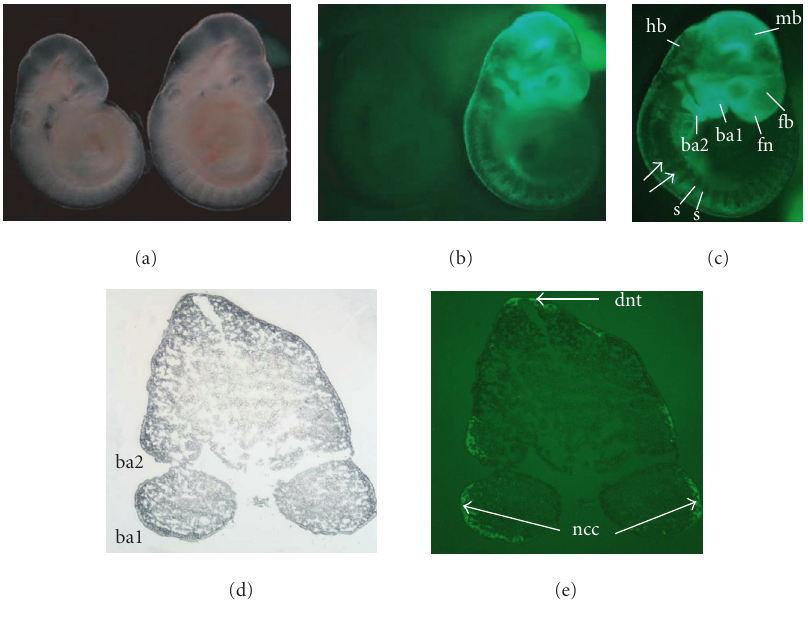
Figure 1. (Top) EGFP-labeled NCC in Wnt 1- Cre/Z/EG transgenic mouse embryos. Photomicrograph of a 9 . 5-dpc, two-component Wnt 1- Cre/Z/EG transgenic embryo (right) adjacent to a wildtype littermate (left) under darkfield optics (a) and epifluorescence optics (b). (c) A 9 . 5-dpc, two-component Wnt 1- Cre/Z/EG transgenic embryo photographed under epifluorescence optics showing EGFP expression in the NCC of the first and second branchial arches (ba1 and ba2), and in the NCC in the forebrain (fb) and from frontonasal (fn) region as well as in Wnt1 expressing cells of the midbrain/hindbrain (mb and hb). EGFP-labeled NCC are also migrating from the CNS between the somites (s) to form the dorsal root ganglia (arrows) at all somitic levels. (Bottom) Transverse section through the region of the first and second branchial arches (ba1 and ba2) (X40) of a 9 . 5-dpc, two-component Wnt 1- Cre/Z/EG transgenic embryo. Tissue sections were visualized under brightfield (d) and epifluorescence (e) optics. EGFP fluorescence is visible in peripheral neural crest cells (ncc) and in the dorsal neural tube